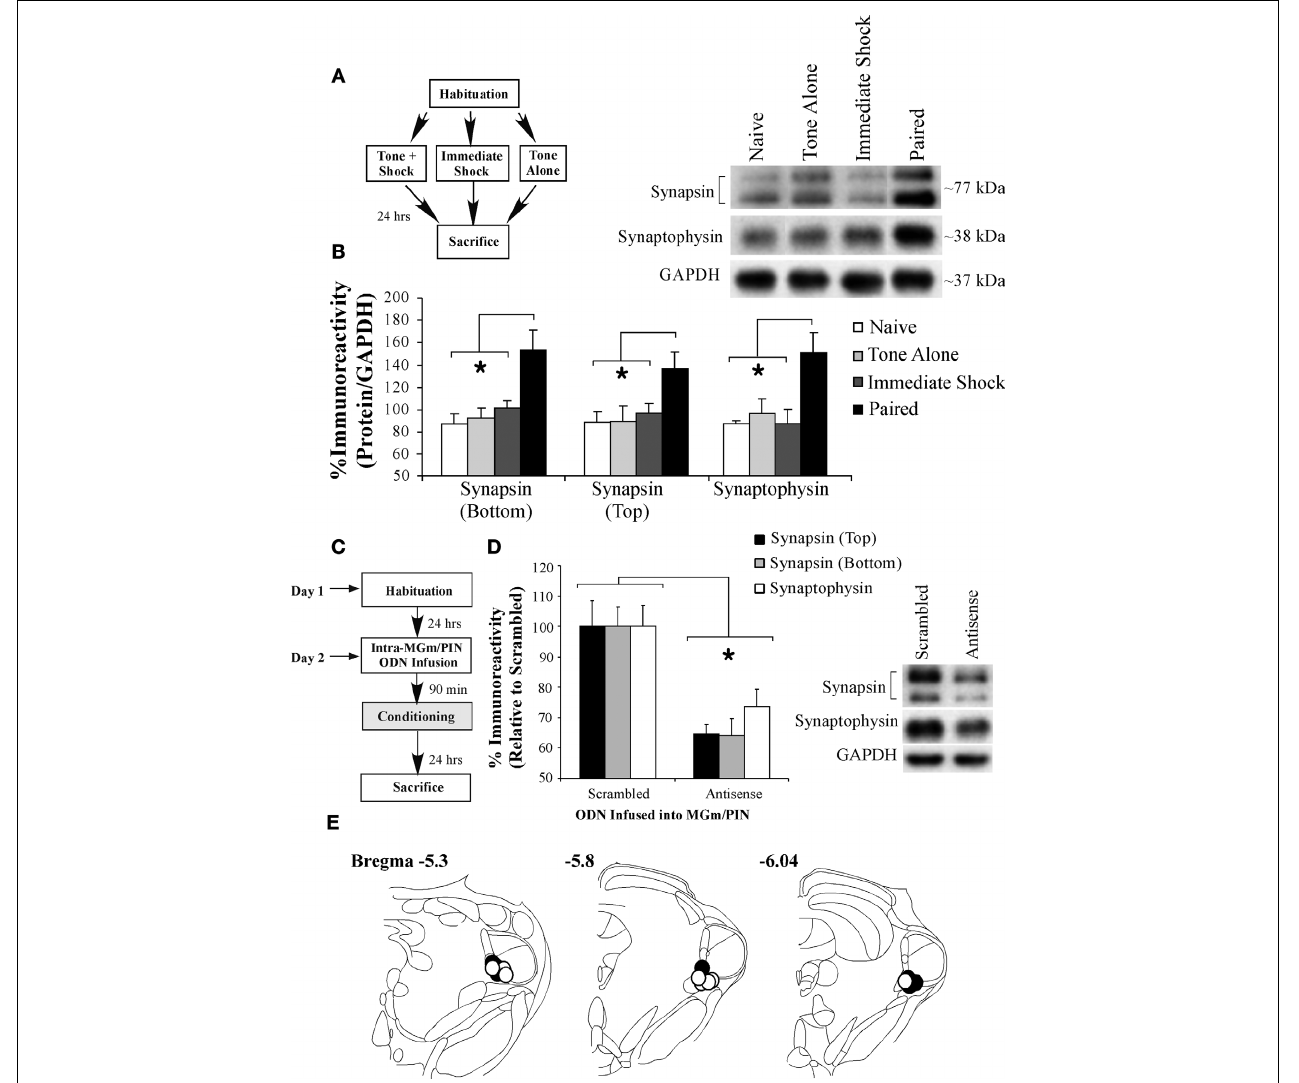
FIGURE 6 | Intra-MGm/PIN infusion of an EGR-1 antisense ODN impairs training-induced elevation of presynaptically localized proteins in the LA. (A) Schematic of the behavioral protocol. (B) Western blot analysis of synapsin (top and bottom bands) and synaptophysin proteins in the LA of Naïve ( n = 6), Tone Alone ( n = 8), Imm. Shock ( n = 8), and Paired ( n = 7) groups. * p < 0.05 relative to the Paired group. Representative blots can be seen in the inset. (C) Schematic of